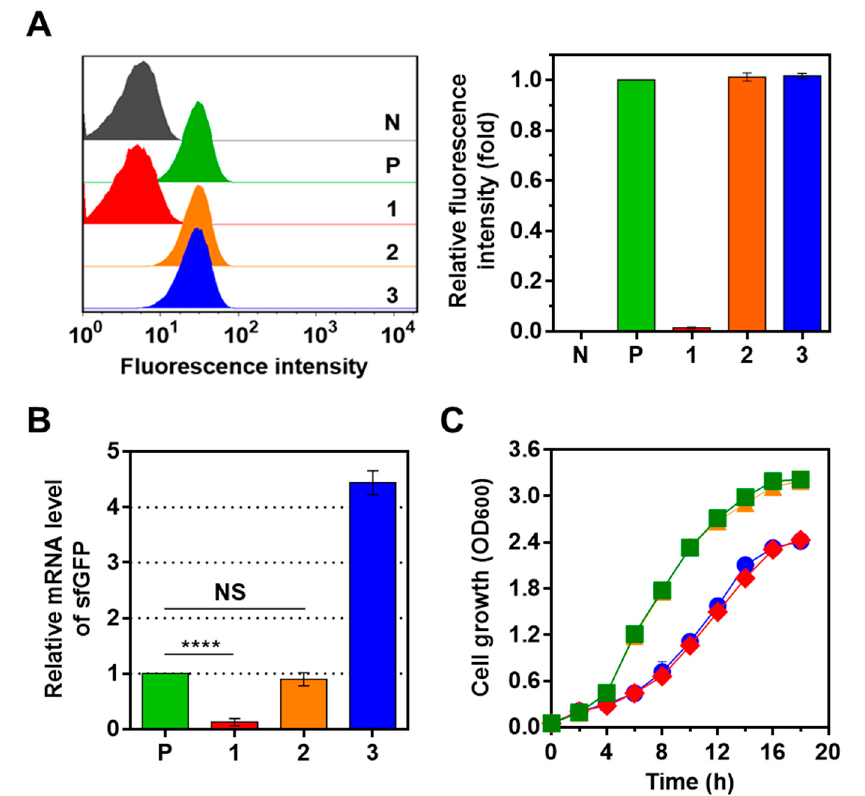
Figure 2. (A) The histogram of fluorescence-activated cell-sorting (FACS) analysis for sfGFP expression. The fold changes of fluorescence intensity in the FACS analysis were plotted in the right graph. (B) The quantification of sfGFP transcripts by qRT-PCR. NS represents nonsignificant ( p -value > 0.05), **** p -value < 0.0001 based on Student t -test. N, L. citreum CB2567; P, L. citreum JW001; 1, L. citreum